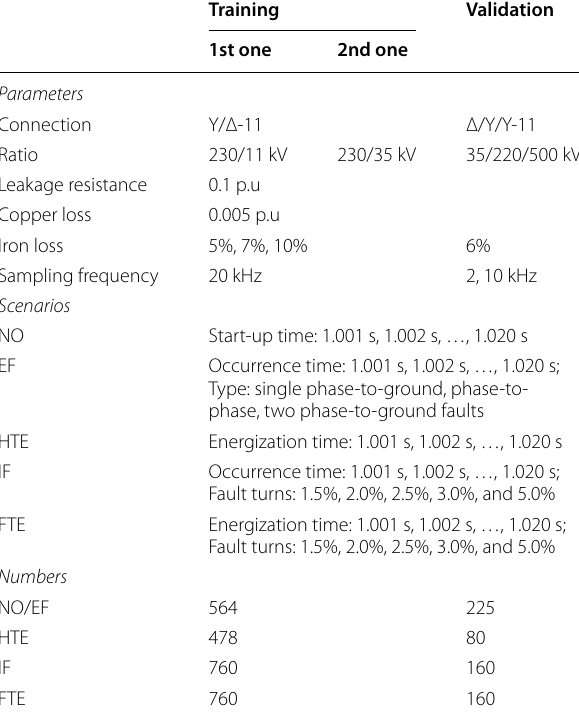
Table 5 Training and validation samples in PSCAD